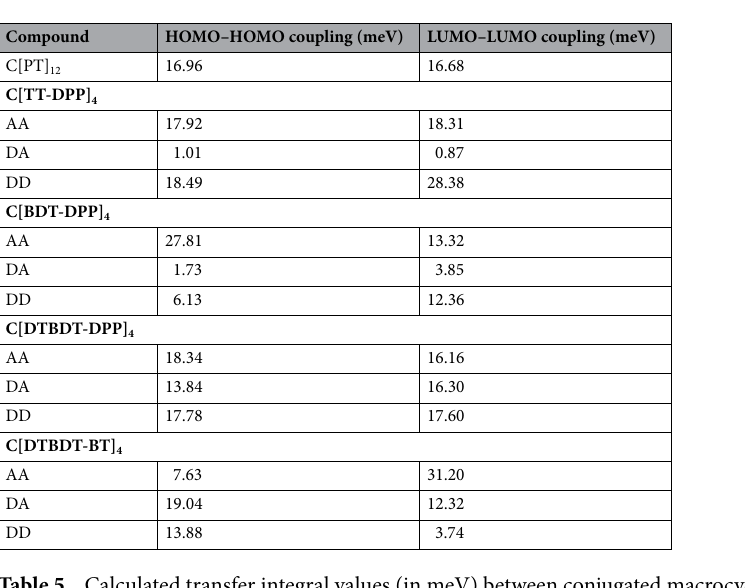
Table 5. Calculated transfer integral values (in meV) between conjugated macrocycles at B3LYP/6-31G** level of theory.